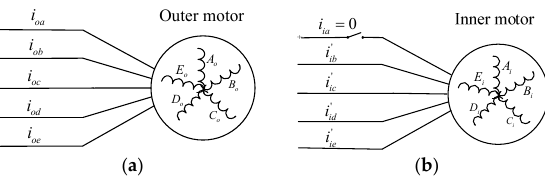
Figure 14. Single ‐ phase open ‐ circuit in inner motor. ( a ) Outer motor; ( b ) inner motor. Figure 14. Single-phase open-circuit in inner motor. ( a ) Outer motor; ( b ) inner motor. The same fault tolerant technique is adopted as single ‐ phase open ‐ circuit in the outer motor.